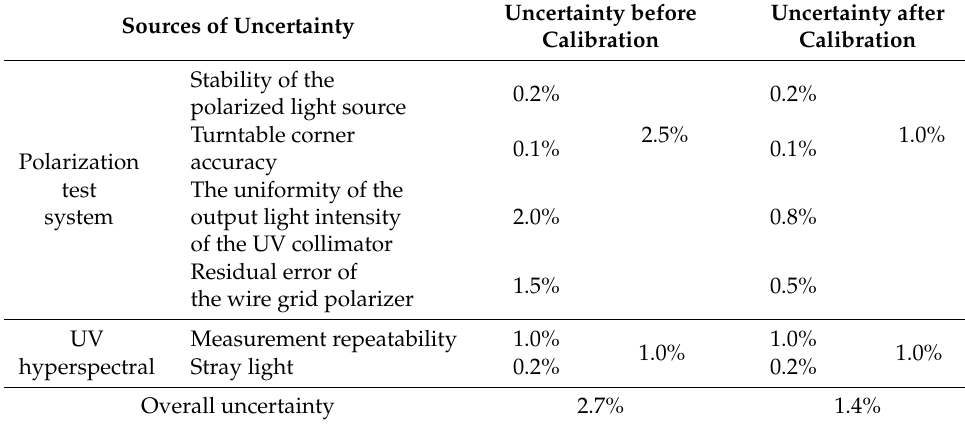
Table 3. Influence extent of each